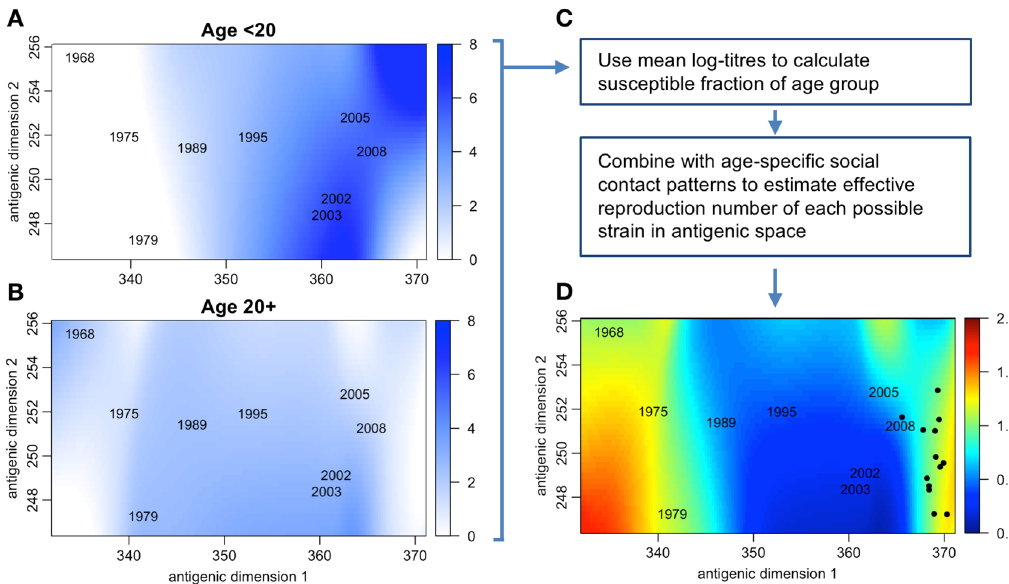
Fig 2. Using serology and social contacts to explore the evolutionary dynamics of influenza A/H3N2. (A, B) Mean log neutralization titer in age < 20 and 20+ groupsmeasuredin 2009 against 9 strains in different antigenic locations,calculatedusing an “antibodylandscape” smoothingtechnique[7]. Data from 151 individualsin Guangdong, China [8,26];year labelsshow antigeniclocationof the 9 test strains used to estimate the landscape. (C) Log titers can be convertedinto the proportionof each group susceptible against each strain [15] and combiningwith age-stratified social-contact data [11] to calculatethe effective reproduction number (definedas the averagenumberof secondary cases generatedby a typical infectioushost) for each strain location.(D) Effective reproduction number for different strains in antigenic space. Black dots show locationsof strains that circulatedin the 2 years after serologicalsamples were collected(i.e., 2009–2011) [7]. The basic reproductionnumber(i.e., the averagenumberof secondary cases generatedby a typical infectioushost in a fully susceptiblepopulation) is assumed to be 2. Code and data are available at: https://github.com/adamkucharski/antigenic-evo.